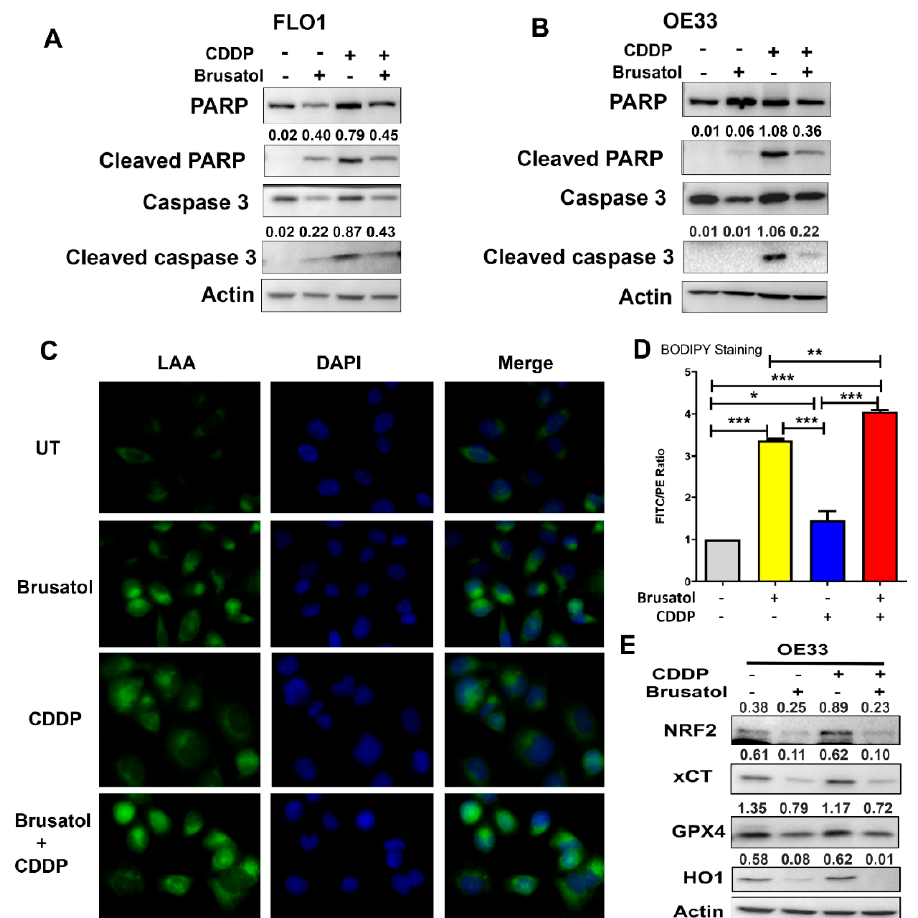
Figure 6. Brusatol treatment induced significant ferroptosis in addition to apoptosis. ( A , B ) Western blotting analyses of apoptotic markers, cleaved PARP, and cleaved caspase 3 in FLO1 ( A ) and OE33 ( B ) cells. Data show that although Brusatol and CDDP combination induced much more cell death, the two apoptotic markers were lower than that in cells treated with CDDP alone, suggesting that other types of cell death occurred, in addition to apoptosis. ( C ) The LAA lipid peroxidation assay displays the level of lipid peroxidation (green signaling). ( D ) A summary graph of the flow cytometry results using BODIPY ® 581/591 C11 (a lipid peroxidation sensor), confirming the significant peroxi- dation levels induced by Brusatol alone and Brusatol in combination with CDDP. ( E ) Western blotting analyses of two known ferroptosis markers, xCT and GPX4, validated the ferroptosis induced by Brusatol or Brusatol in combination with CDDP. The numbers above each band in ( A , B , E ) indicate the relative band intensity as normalized to the intensity of the loading control, Actin. * p < 0.05; ** p < 0.01; *** p <